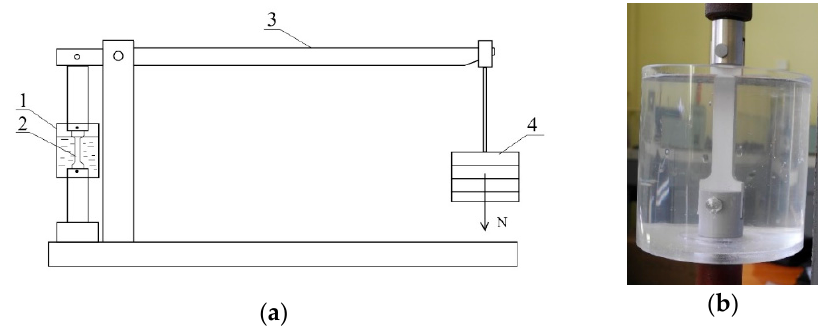
Figure 2. Stand for testing the stress corrosion resistance of AlMg6 alloy, ( a ) test bench scheme for σ = const., 1—container filled with 3.5% of NaCl, 2—sample, 3—lever arm, 4—load, ( b ) container filled with 3.5% of NaCl in which the sample is located.